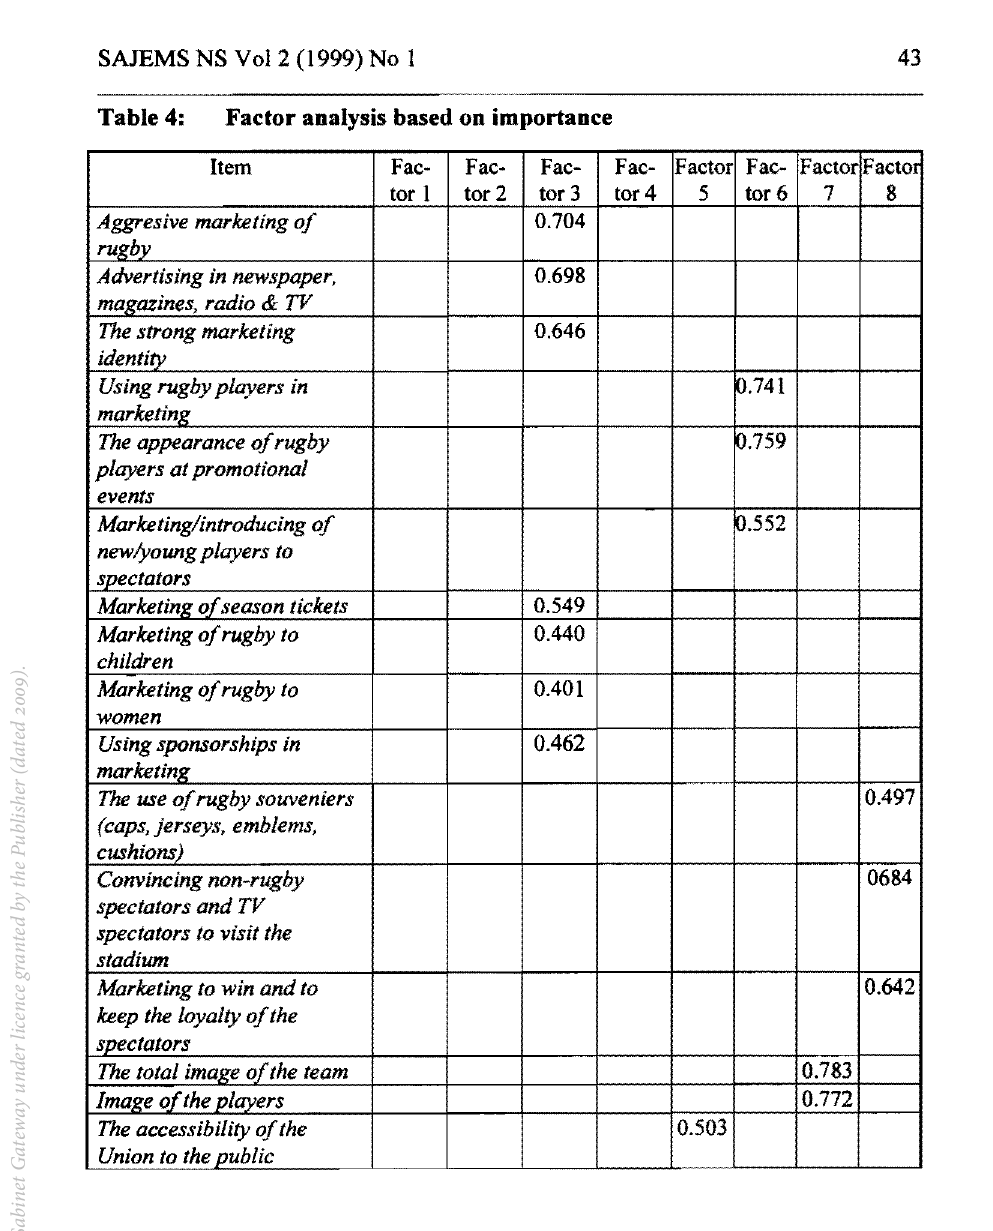
Table 4: Factor analysis based on